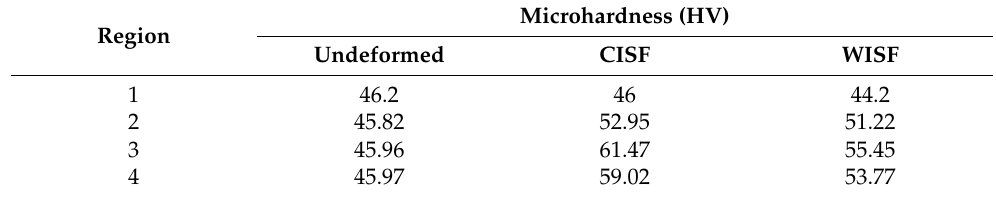
Table 11. Average microhardness obtained in different regions of the formed cones.